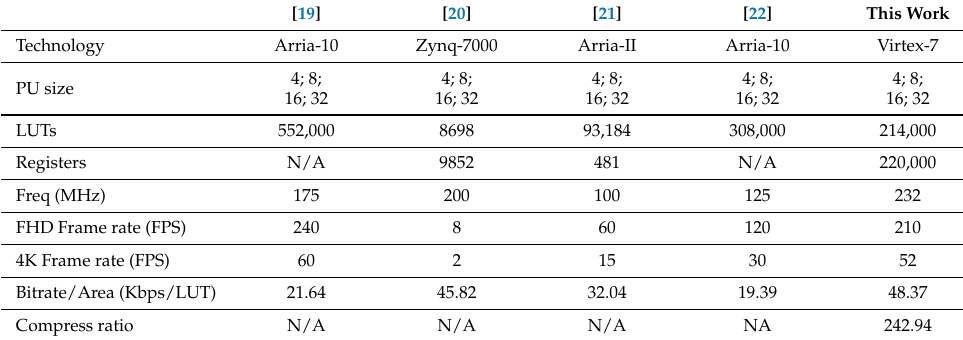
Table 6. Synthesis results and comparison with the other FPGA implementations